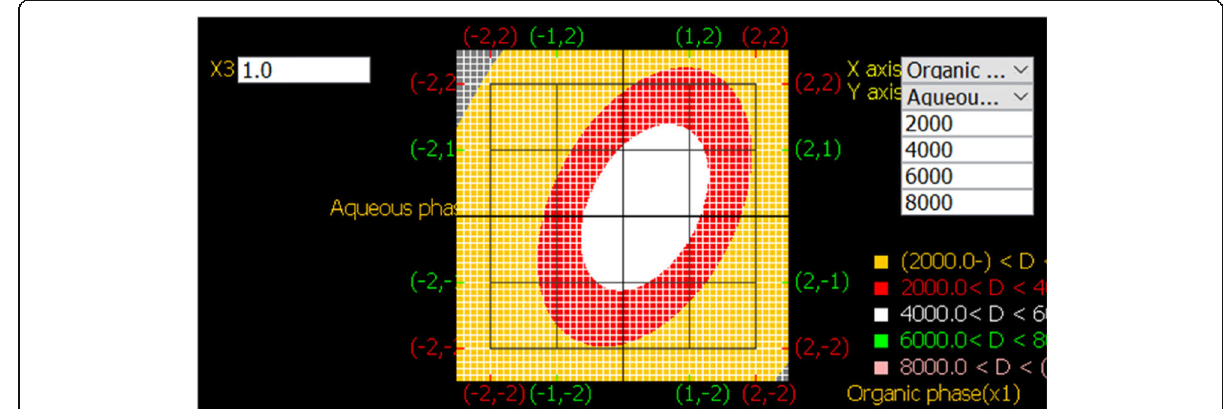
Fig. 4 Contour plot of daclatasvir at 1.0 ml flow rate